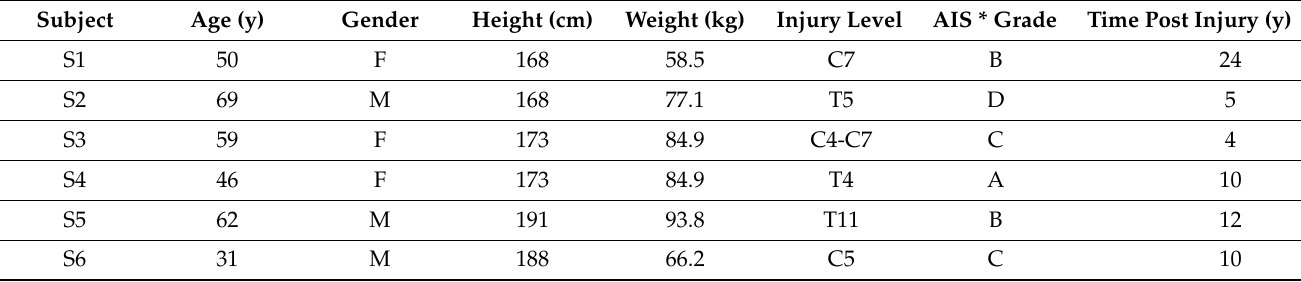
Table 1. Clinical characteristics of the study